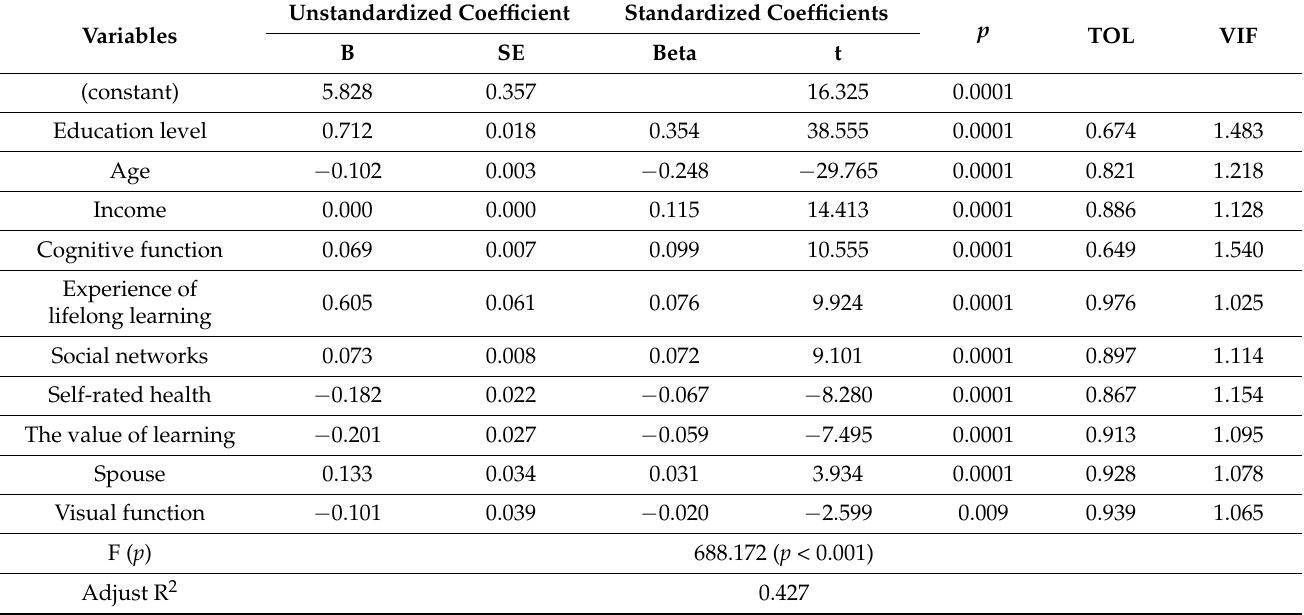
Table 6. Factors influencing DCE competence ( n =